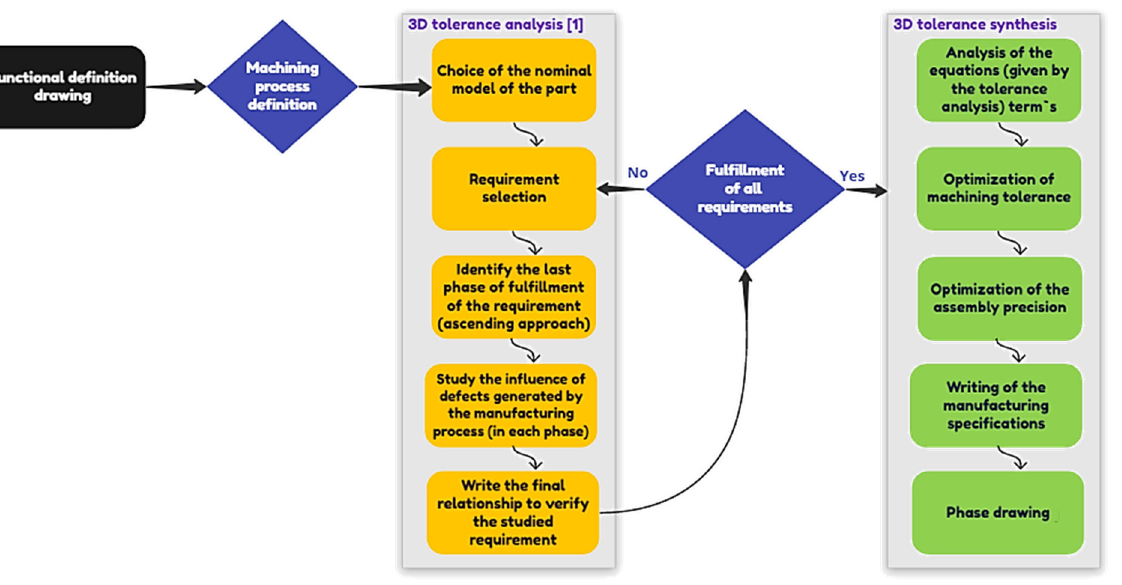
Figure 1. Approach flowchart.